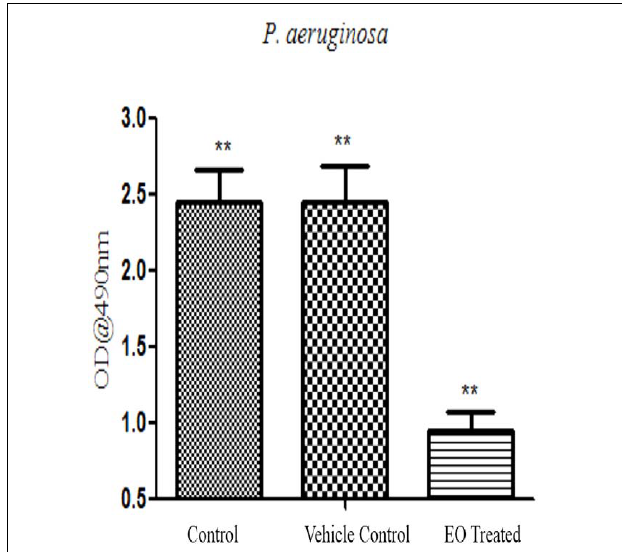
FIGURE 8 | Inhibitory Effect of EO at sub MIC (5% v/v) on EPS production of P. aeruginosa biofilm. Mean values of triplicate independent experiments ± SD are shown. One-way ANOVA test demonstrates significant difference between the control and the test. Double asterisk indicates significant at P ≤ 0.01.